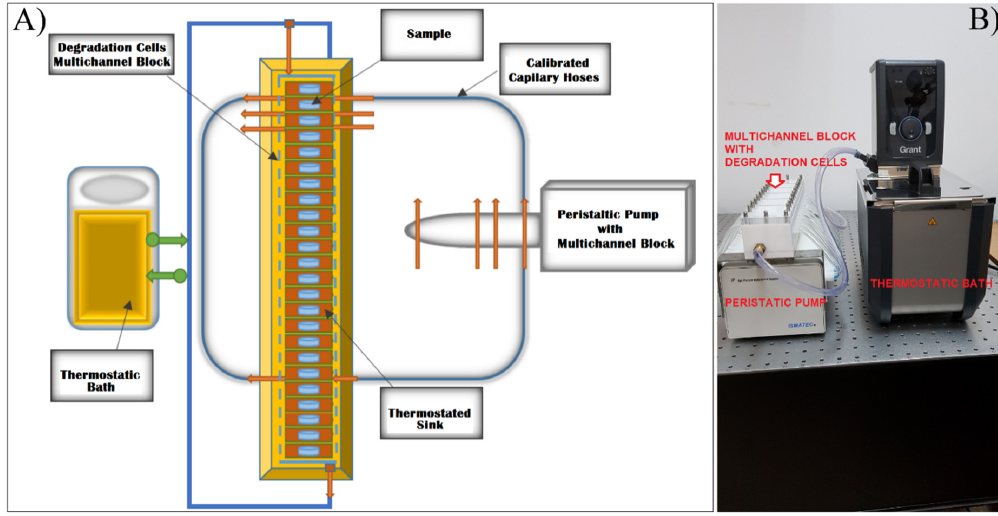
Figure 2. Degradation tests set-up: ( A ) schematic description; ( B ) photograph of the laboratory set-up.